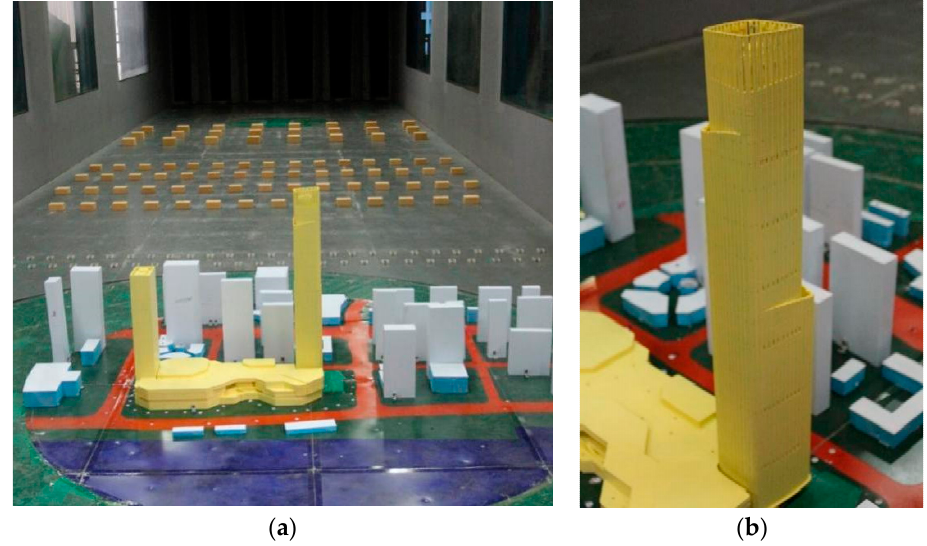
Figure 9. ( a ) Model and surroundings in the wind tunnel. ( b ) Pressure test model. Table 4. Layout of pressure taps.